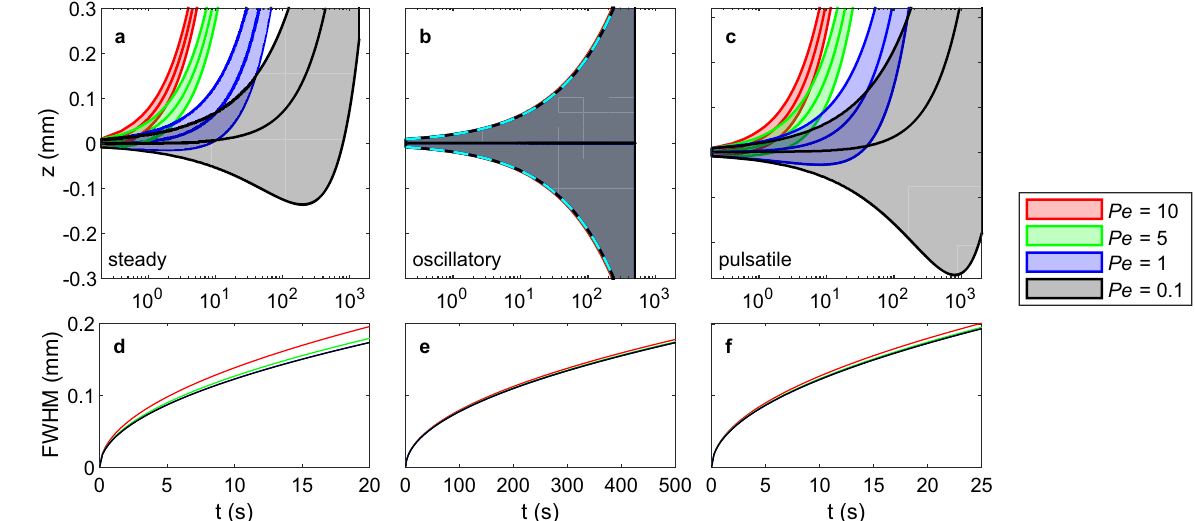
Figure 4. Transport of the solute in the bolus simulations for ( a , d ) steady flow, ( b , e ) oscillatory flow, and ( c , f ) pulsatile flow, at different Péclet numbers. In ( a – c ), the center curves indicate the axial position of the peak axial mean concentration, and the upper and lower curves indicate axial positions where the local concentration is half of the maximum concentration. Peaks move at constant speed, although their trajectories appear as curves on the semi-logarithmic axes used to accommodate the very different timescales for flows of different Péclet number. The full width at half-maximum (FWHM), defined as the distance between the upper and lower curves, and is plotted in ( d – f ). The rate of increase of the FWHM slows continuously in all cases. In ( b ), all cases have nearly identical FWHM and are shown in the same manner as ( a , c ). The dashed light blue curves depict the analytical FWHM for pure diffusion. For all three flow types, the FWHM is greatest for the case with highest 0.1 and Pe 1 nearly overlap. Note that the horizontal axis in each plot depicts Péclet number. Curves for Pe = = time, but the limits for the FWHM plots are truncated to the duration of the shortest simulation for each flow type.